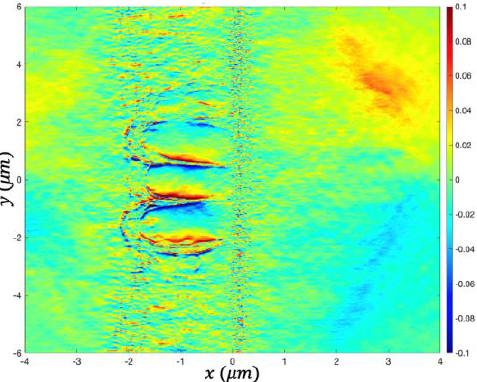
Figure 10. Transverse electric field normalized to the Tajima-Dawson field, 𝐸 𝑇𝐷 = 𝑚 𝑒 𝑐𝜔 𝐿 /𝑒, at 400 fs exhibits high degree of coherence and large amplitude (0.2 × 𝐸 𝑇𝐷 ) later in time.